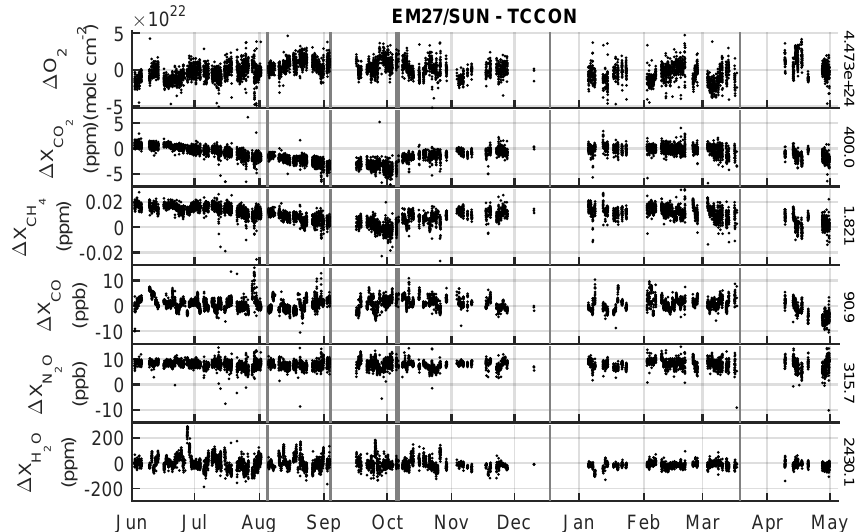
Figure 8. Full time series of EM27/SUN measurements as compared to TCCON from June 2014 to May 2015. Thin vertical gray lines represent mirror cleaning. The thick line represents the mirror change. To the right are TCCON means over time to get a sense of percent